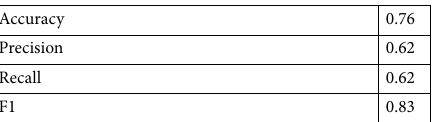
Table 4. Cross-validation performance on a dataset from Barcelona containing 100 2nd trimester ultrasound